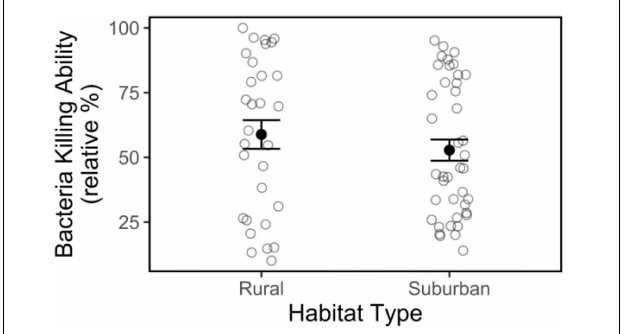
FIGURE 6 | Bacteria killing ability of plasma from male song sparrows from rural and suburban sites. Closed circles and whiskers are mean ± SE; open circles are measurements of individuals birds. No significant habitat differences were